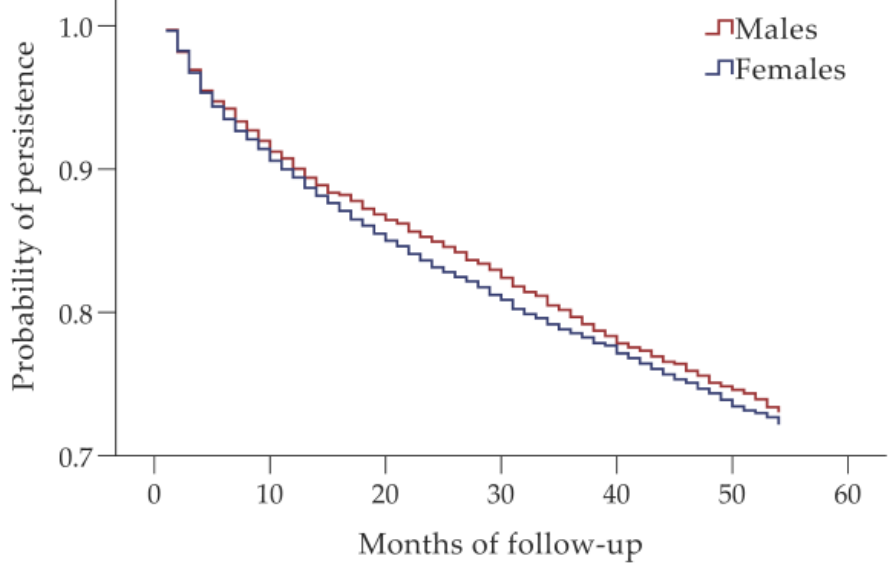
Figure 2. Persistence with angiotensin-converting enzyme inhibitors/angiotensin receptor blockers in males and females.